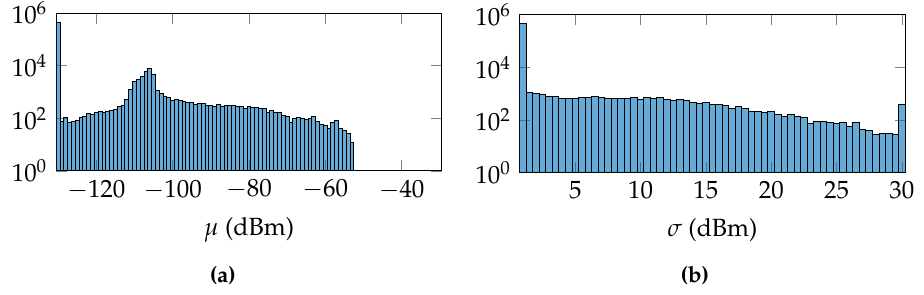
Figure 4. The histograms of parameters µ , ( a ) and σ , ( b ) after the training procedure in the UJIIndoorLoc dataset, with the uncertainty of the antenna gain incorporated and using a region of reference